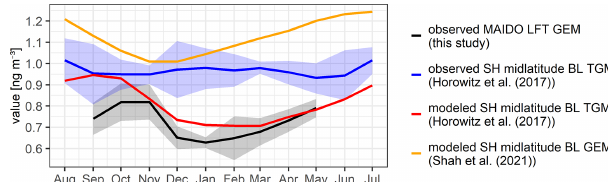
Figure 4. Comparison between observed and modeled Hg season- alities in the SH. The abbreviations LFT and BL correspond to “lower free troposphere” and “boundary layer”, respectively. Ob- served TGM seasonality as digitized from Horowitz et al. (2017) corresponds to observations from Amsterdam Island and Cape Point. The shaded areas give the mean ± 1 standard